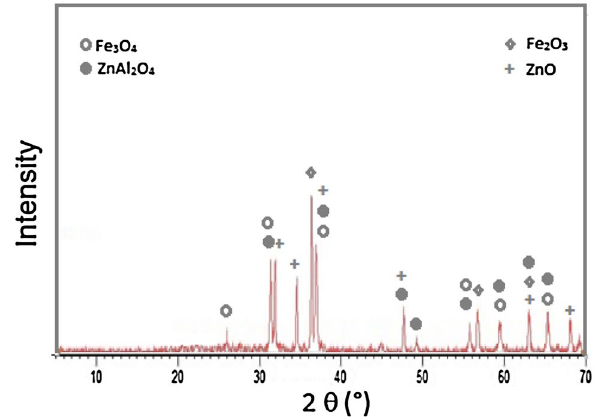
Fig. 11 XRD pattern of the phase [Zn–Al–AG1] calcined at 1200